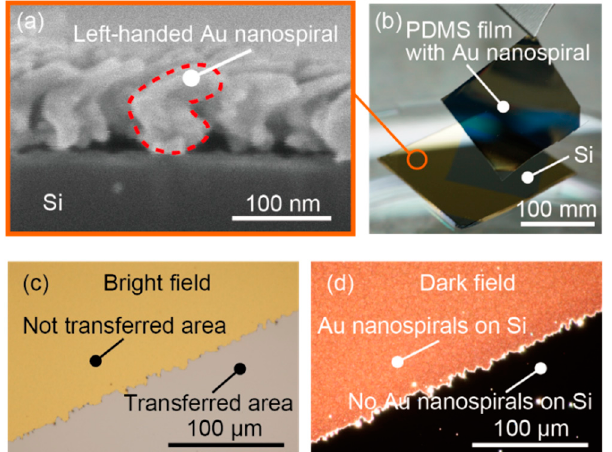
Figure 5. A thin, single-layered circular dichroic filter was fabricated by transferring the Au nanospiral structure fabricated on a Si substrate onto a flexible and transparent PDMS thin film. ( a ) SEM image of a side view of the left-handed Au nanospiral structures with a diameter of 70 nm on a Si substrate. ( b ) Transferred Au nanospiral structures. ( c ) A photo of the substrate after transferred to a PDMS thin film taken with an optical microscope with bright field. ( d ) A photo of the substrate after transferred to a PDMS thin film taken with an optical microscope with dark field.